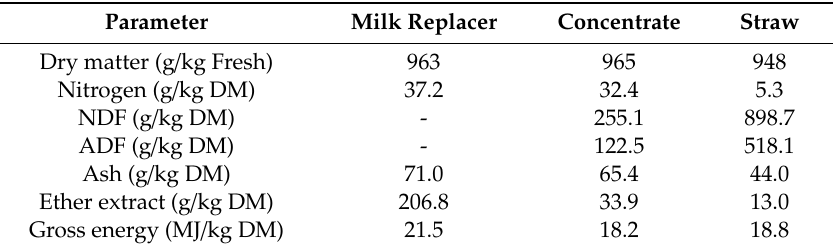
Table 2. Chemical composition of milk replacer, concentrate and straw o ff ered to calves allocated to a gradual or abrupt weaning protocol throughout the experimental